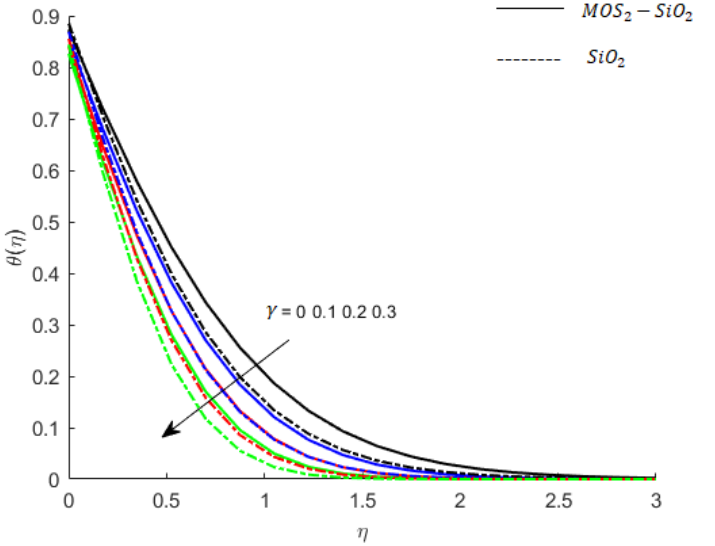
Figure 10. Influence of γ on temperature when M = 0.9, Pr = 0.9, Ec = 0.2,Sc = 0.8, Ei = 0.1, K = 0.1, Bi = 0.05, β ∗ = 0.1.